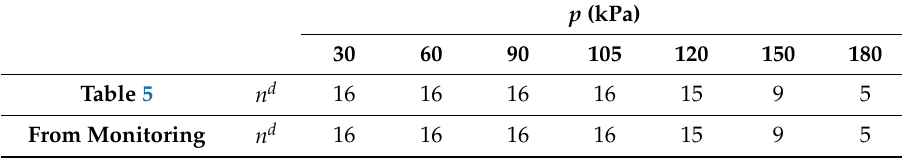
Table 10. Comparison of n d for